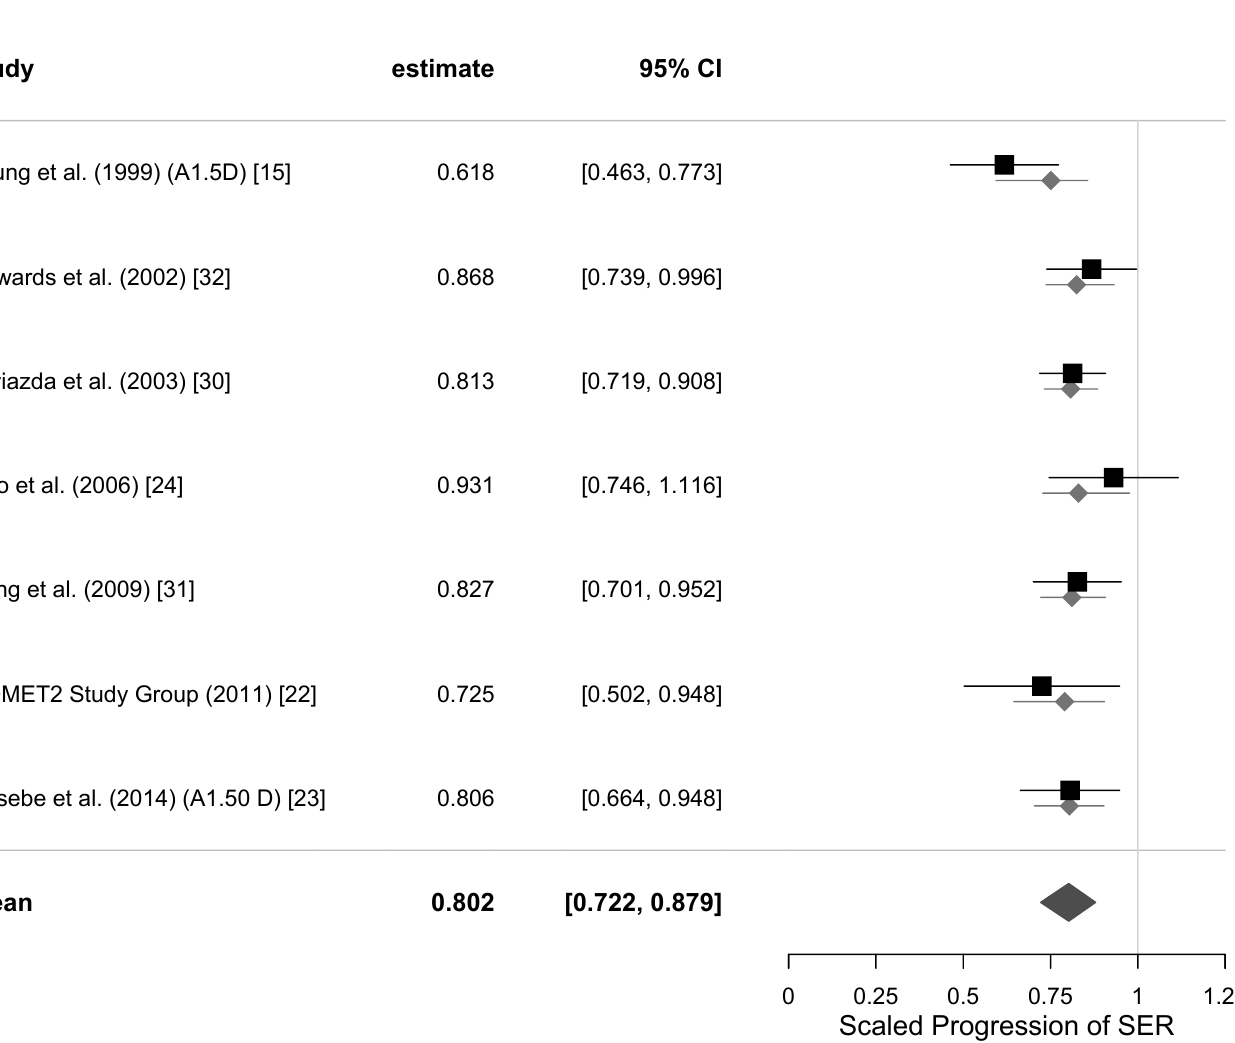
Figure 3. Forest plot for the scaled progression of sphere equivalent refraction (SER) at 24-months follow-up with all the trials